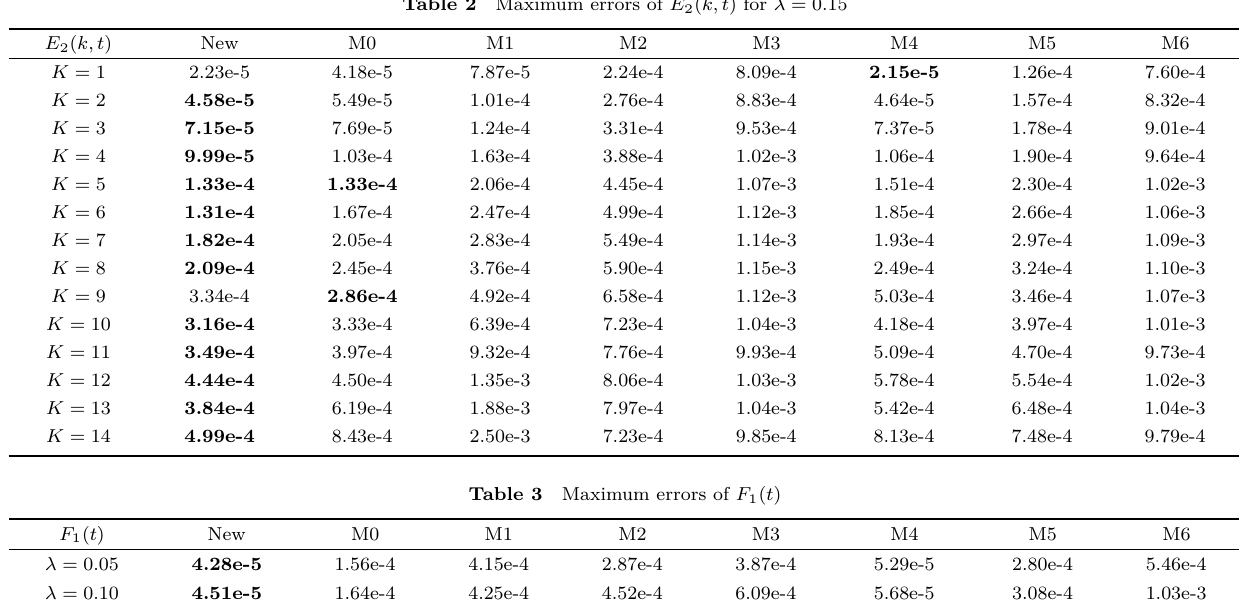
Table 2 Maximum errors of E 2 ( k,t ) for λ = 0 . 15